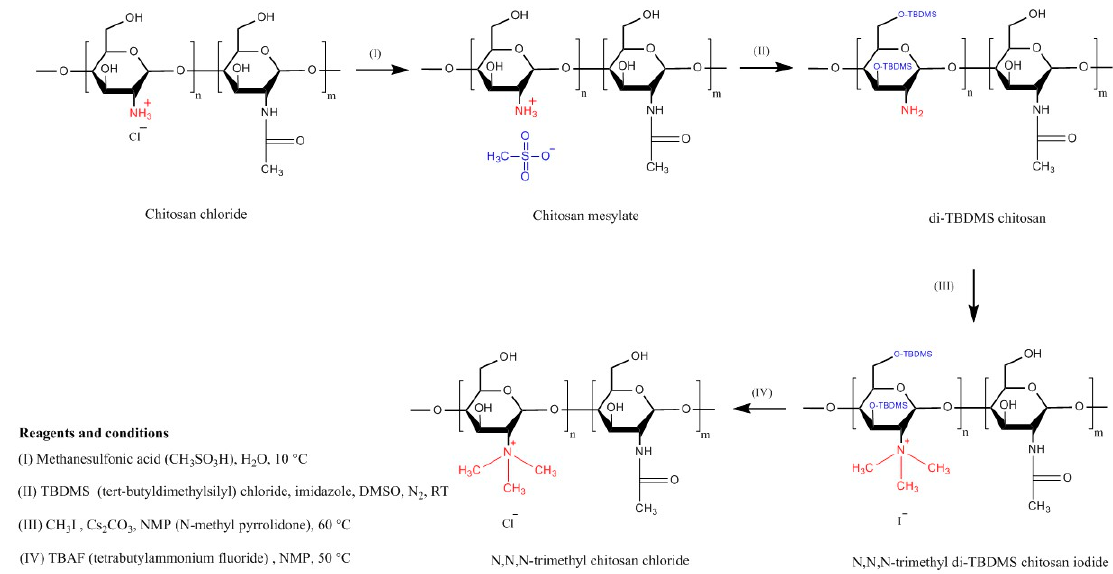
Figure 6. Synthetic pathway for preparation of TMC using hydroxyl groups protection approach by O -silylation according to Benediktsdóttir et al. [54].